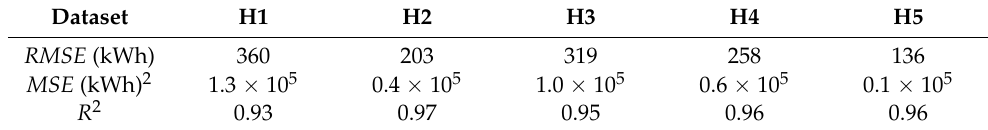
Figure 8. Correlation matrix used for feature selection.